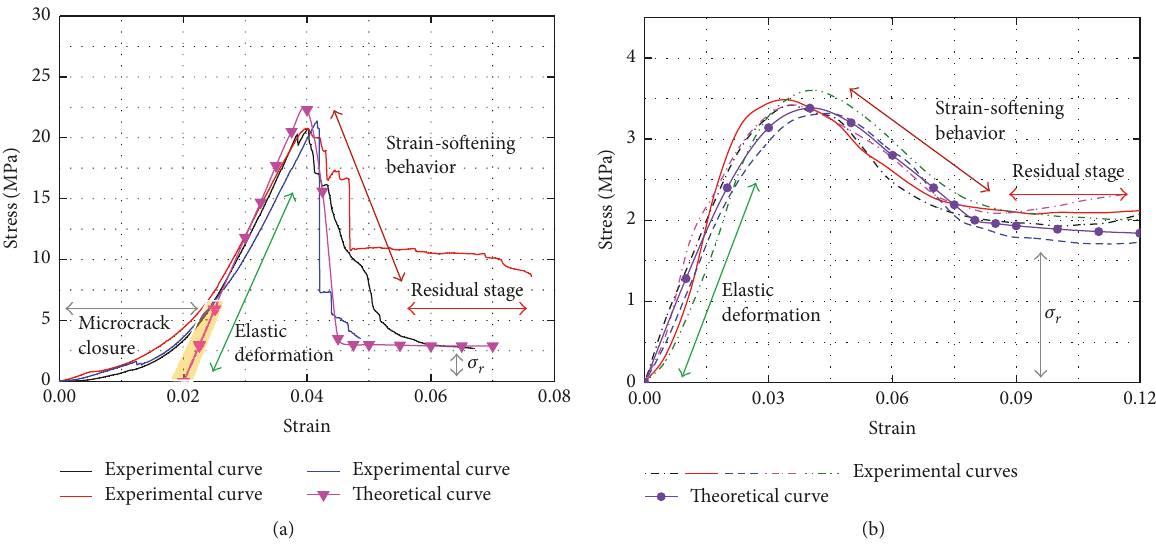
Figure 6: Strain-stress curves of experimental and theoretical data. (a) Stress-strain curves of coal under PSBSS; (b) stress-strain curves of synthetic material under